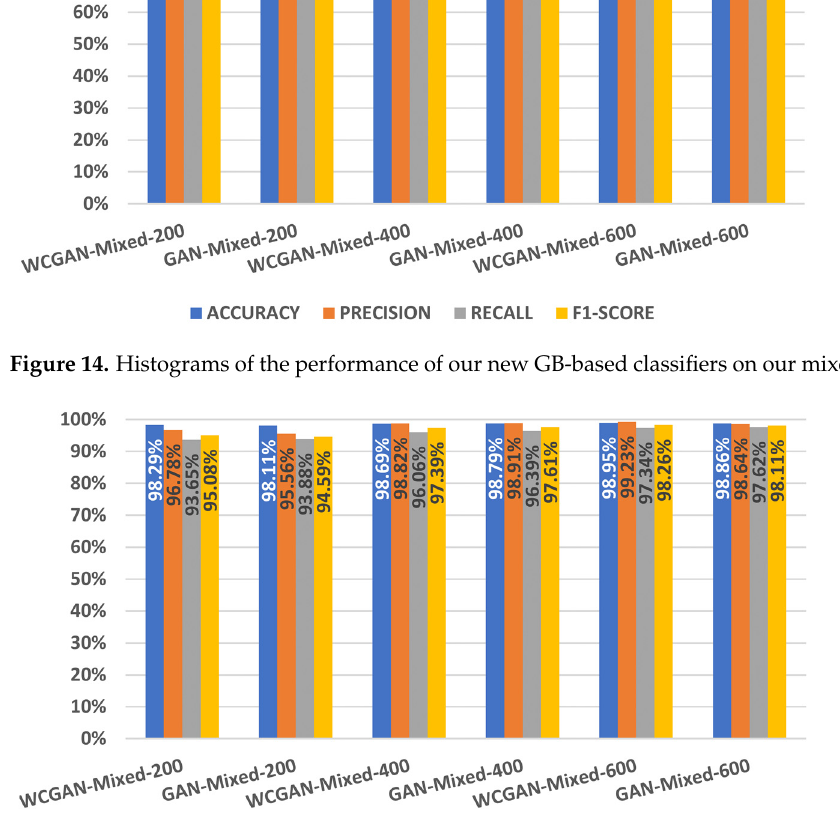
Figure 16. Histograms of the performance of our 13 GB-based classifiers on our 13 test sets.